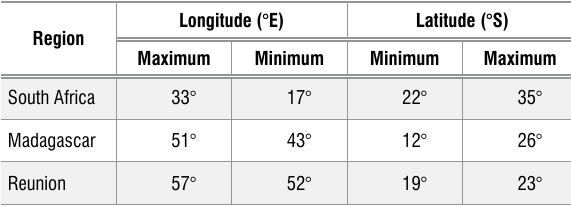
Figure 1. (For further information on the TES instrument, the reader may visit the web page http://tes.jpl.nasa.gov.)